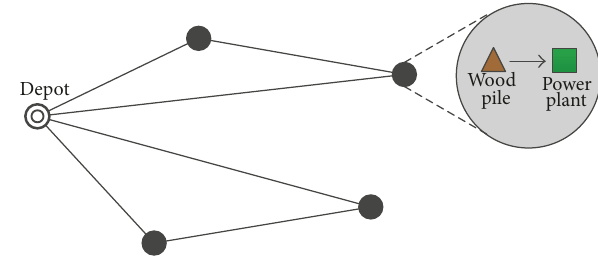
Figure 2: Example of geographic dispersion of